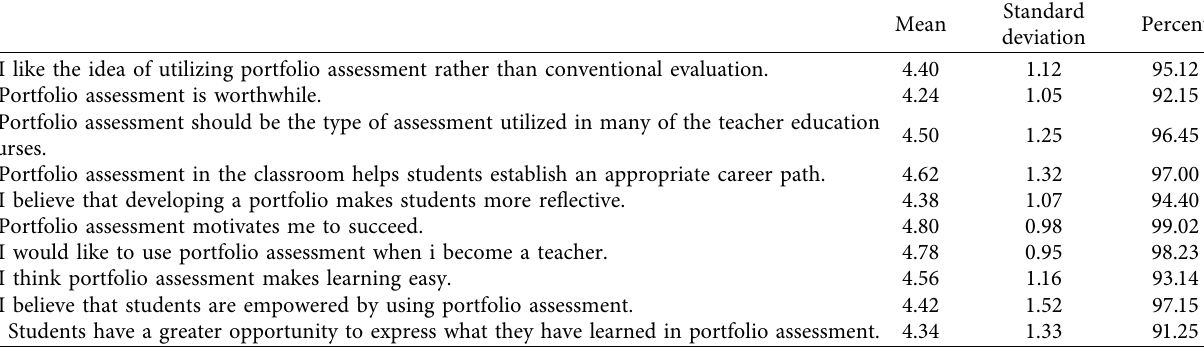
Table 5: Results of the participants’ attitudes toward using